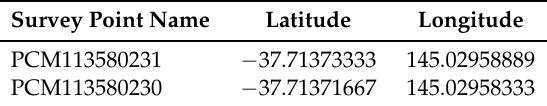
Table 2. Locations of survey points.